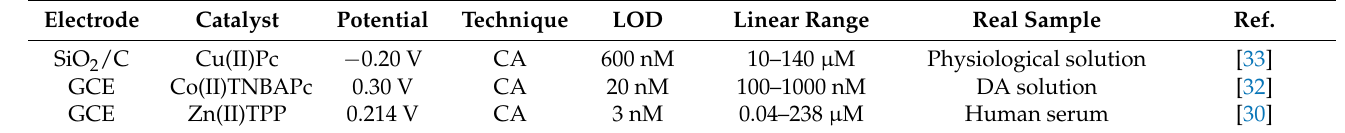
Table 3. Examples of MP and MPc used in the modification of electrodes for detection of dopamine. Electrode Catalyst Potential Technique LOD Linear Range Real Sample